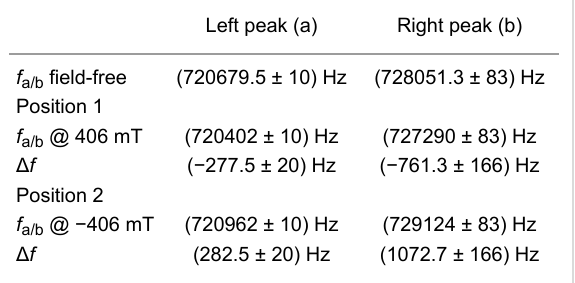
Table 2: Measured resonance frequencies f a/b of the coupled system for both orientations of the magnet and corresponding frequency shift values Δ f compared to a field-free measurement. The values are given for the highest magnetic